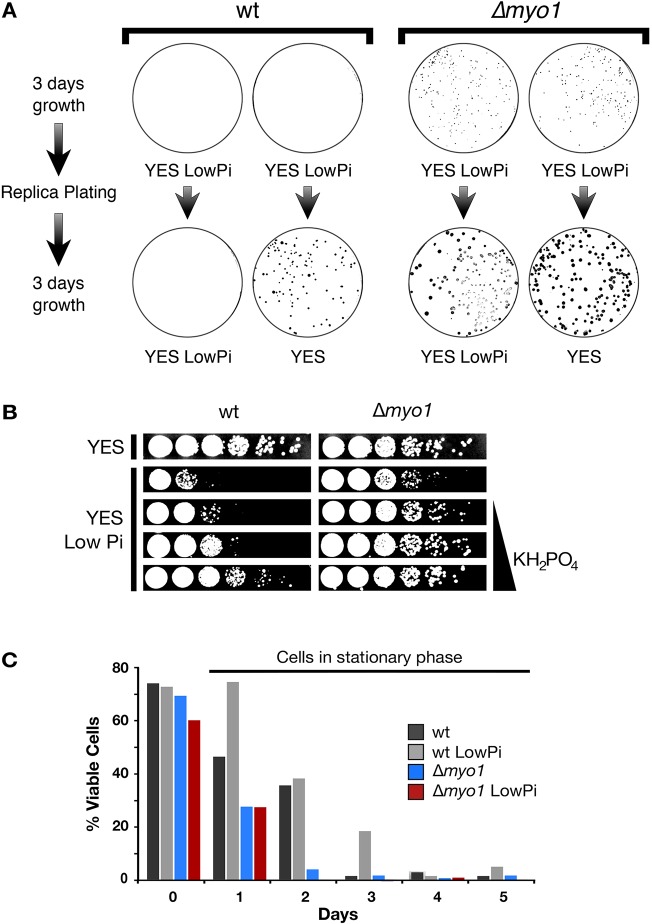
Cells enter a quiescent-like state in the low-phosphate stress condition. (A) ∼300 wild-type (wt) or Δmyo1 cells were plated on low-phosphate YES. After 3 days, cells were replica plated onto either low-phosphate YES or YES (normal phosphate) media and incubated for an additional 3 days (shown here are representative results of three repeat experiments). (B) Serial dilution viability assay testing cellular growth of wild-type and Δmyo1 strains in YES LowPi containing increasing amounts of phosphate (phosphate removed, 1 mM, 5 mM and 10 mM KH2PO4 added). Phosphate was removed from YES as described in the Materials and Methods and was re-constituted with defined amounts of phosphate using KH2PO4. Panels are also shown in Fig. 4A. (C) Cells were grown in YES or YES LowPi media for the indicated amount of time, then cell viability was measured as the percentage of colony-forming units on the total number of cells plated in YES. Two independent experiments have been carried out with similar outcomes; one representative experiment is shown.